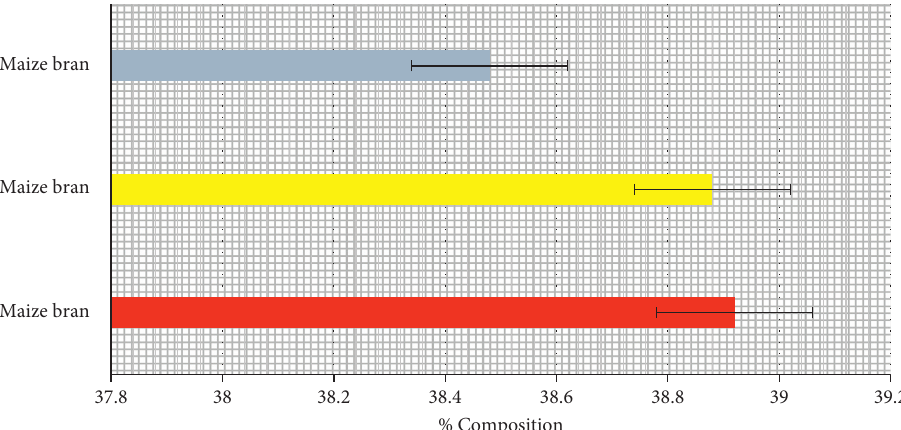
Figure 4: Percentage ash content of poultry-mix.